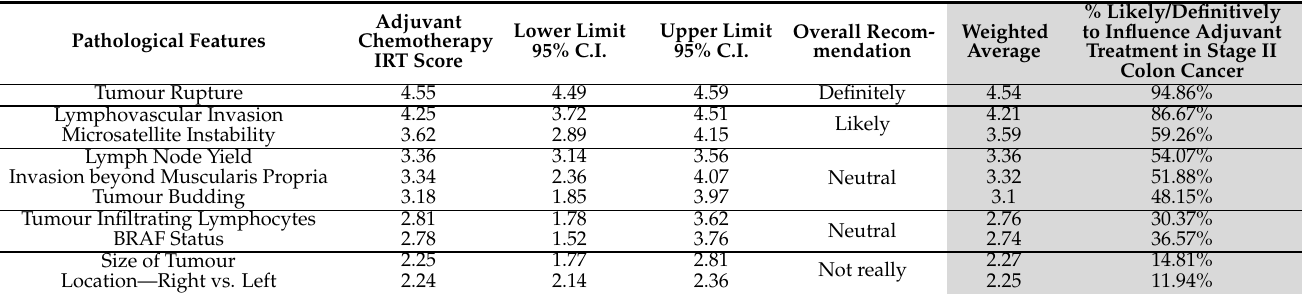
Table 4. Item Response Theory (IRT) and weighted average scores for pathological features influenc- ing decision-making for adjuvant chemotherapy in stage II colon cancer: Adapted from Wiley Cancer Reports—Toh et al. (2020) [8] under the creative commons attribution license (CC